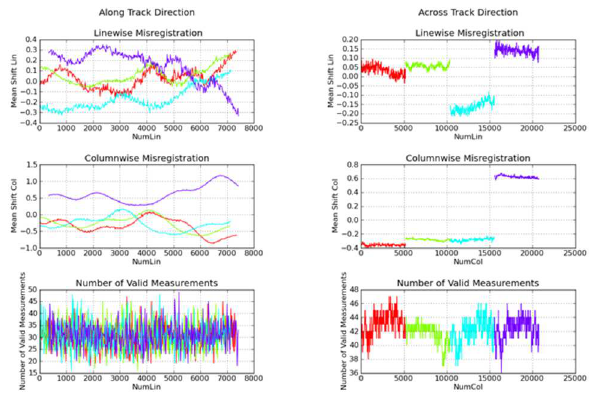
Figure 7 Misregistration profiles of FR-LQ1 image obtained with filtered attitude without attitude correction.